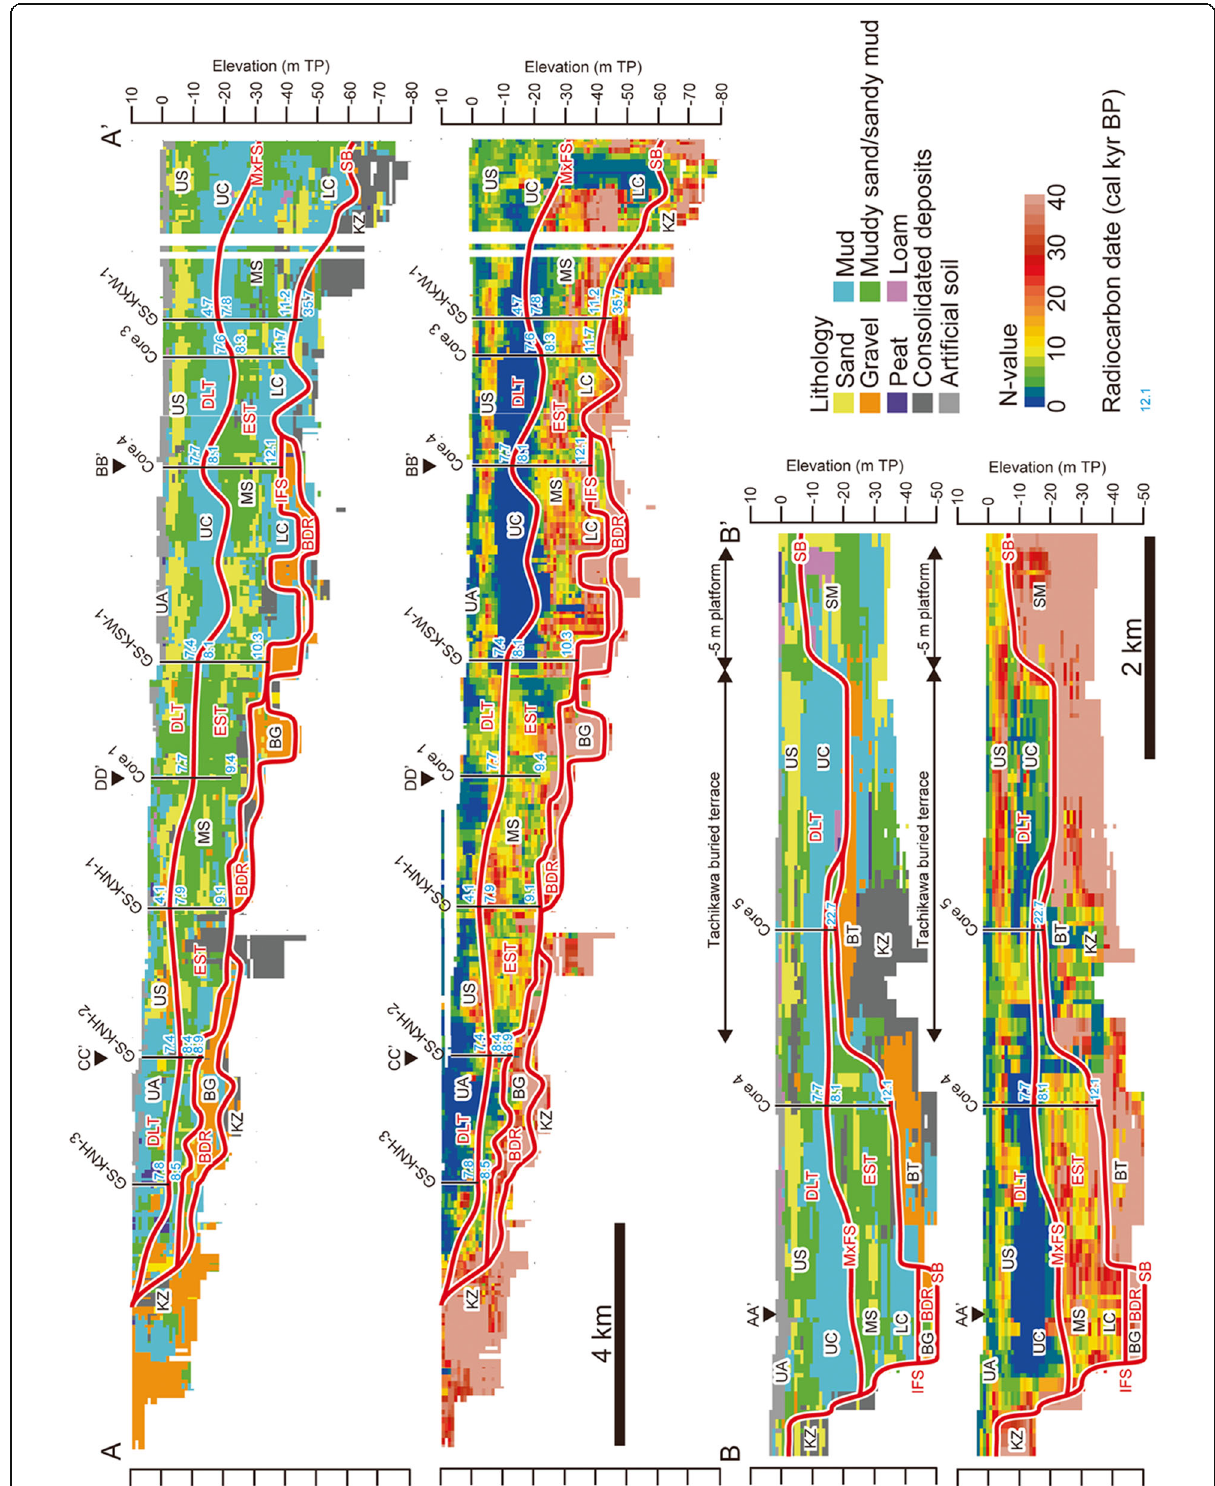
Fig. 6 Cross sections of lithology (upper section in each figure part) and N value (lower section in each figure part) in the Tama River Lowland (sections AA ’ , BB ’ , and CC ’ ), the Tsurumi River Lowland (section DD ’ ), the Owoka and Katabira river lowlands (section EE ’ ), and the Tokyo Lowland (section FF ’ ). The traces of cross sections are reported on Fig. 2. Drilling of most borehole logs ceased at the firm surface of the Kazusa and Shimosa groups; therefore, the lithology and N value of the pre-LGM deposits are not known for most